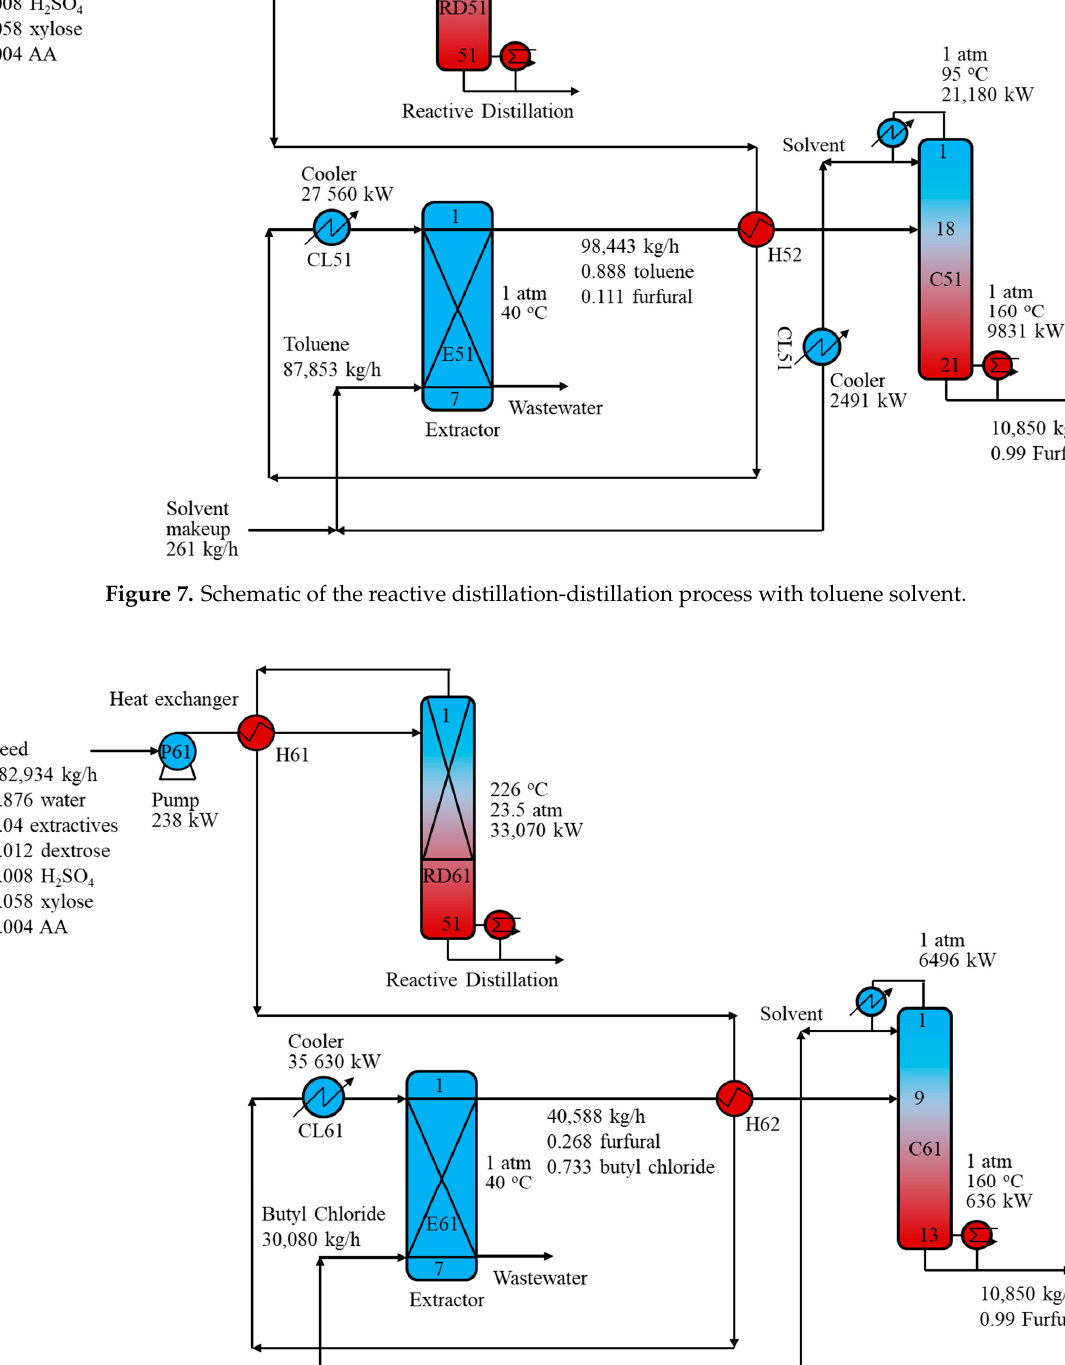
Figure 8. Schematic of the reactive distillation-distillation process with a butyl chloride solvent.